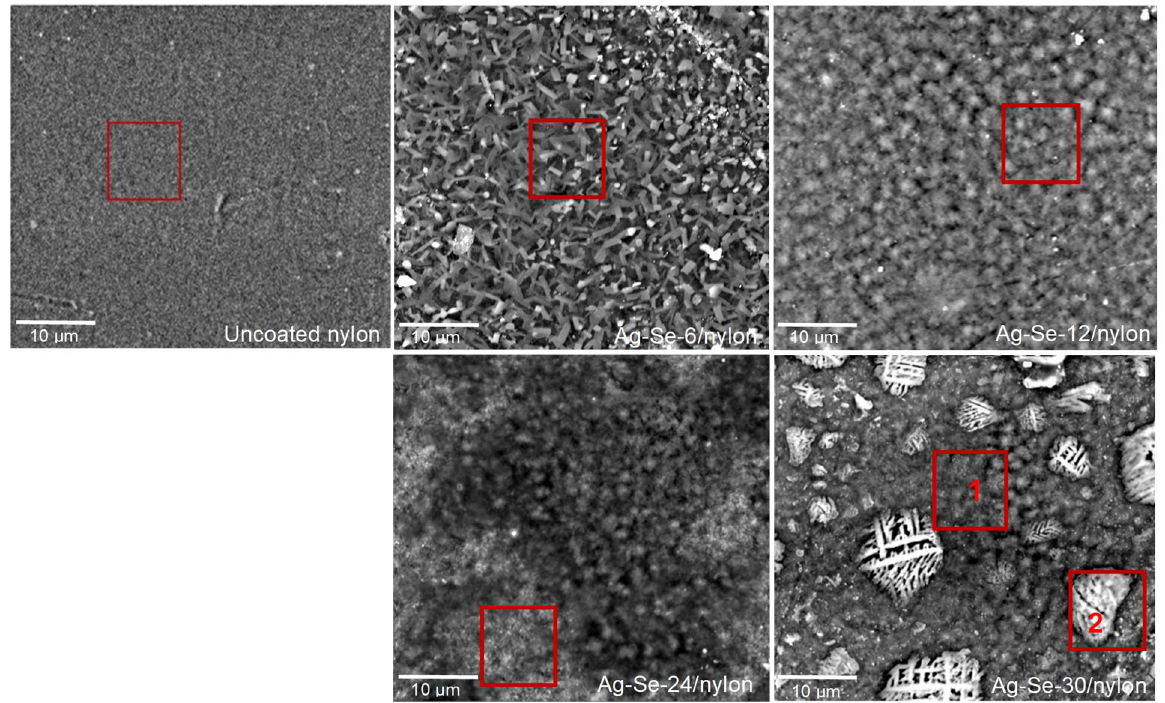
Figure 1. An image of uncoated nylon and obtained Ag–Se/nylon nanocomposites. Magnification 100×.